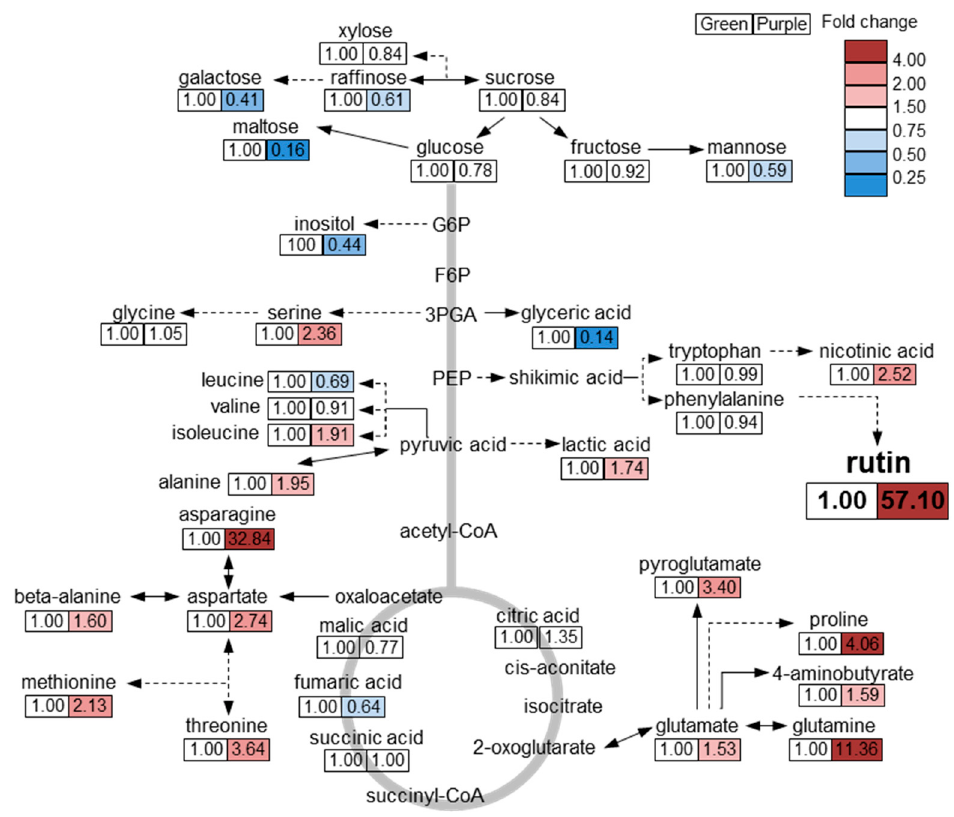
Figure 4. Overview of metabolites differing between green and purple pakchoi. The response ratio of purple to green pakchoi for each metabolite is shown. Red and blue colors indicate ratios of more than 1 and less than 1, respectively.